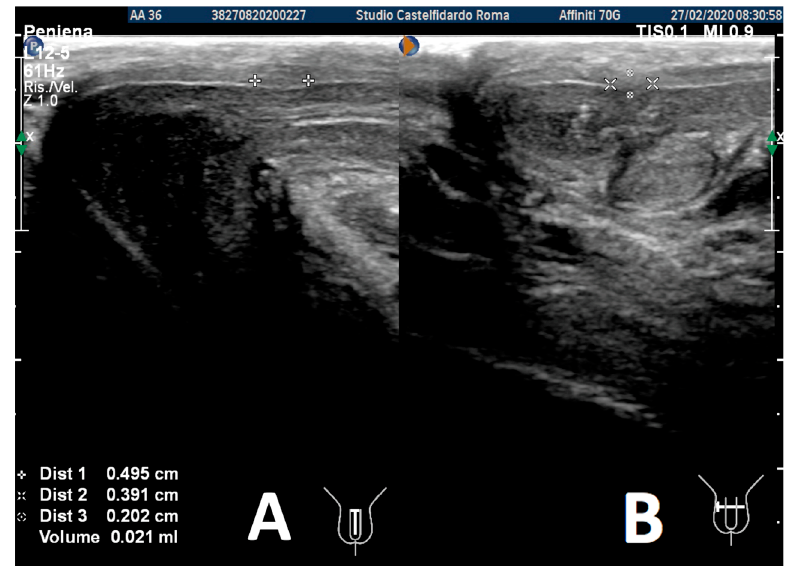
Figure 12. Ultrasonography of the penis after the 3rd therapy cycle. ( A ) Longitudinal view; ( B ) axial view.